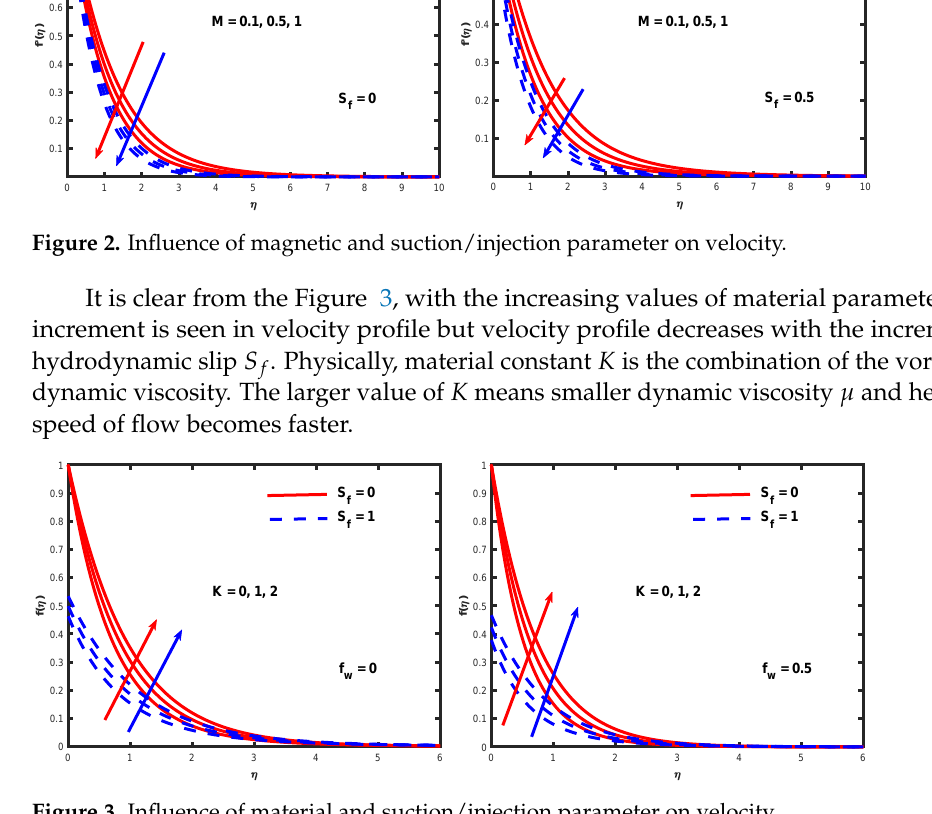
Figure 3. Influence of material and suction/injection parameter on